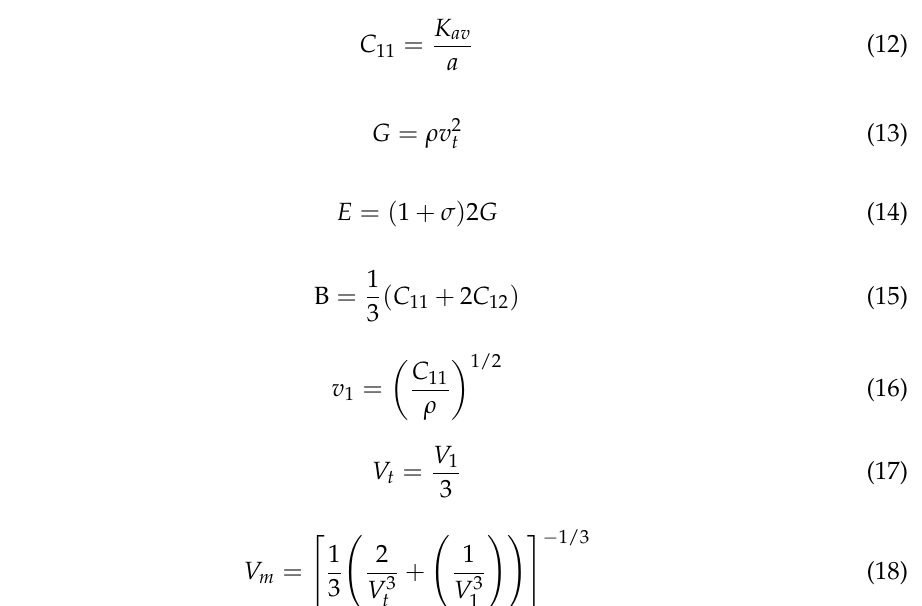
Average force constant ( K av ) was computed from the average of K T and K O (Table 4). The stiffness constant ( C 11 ), bulk modulus ( B ), rigidity modulus ( G ), Young’s modulus ( E ), mean wave velocity ( V m ), transverse wave velocity ( V t ), longitudinal wave velocity ( V l ), Poisson’s ratio ( σ ) were obtained using the relations [47]: